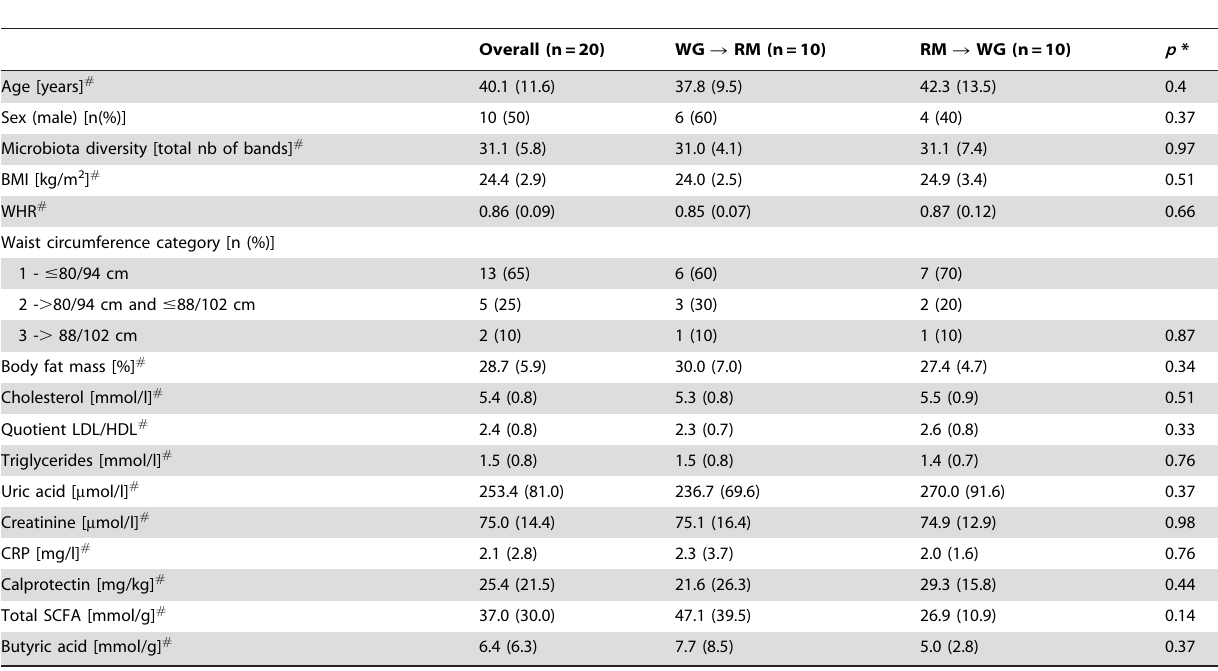
Table 1. Baseline characteristics of study participants, overall and by intervention sequence group after randomisation; # Mean (SD), *pValues for ttest comparing continous variables in the groups and x 2 test for categorical variables.